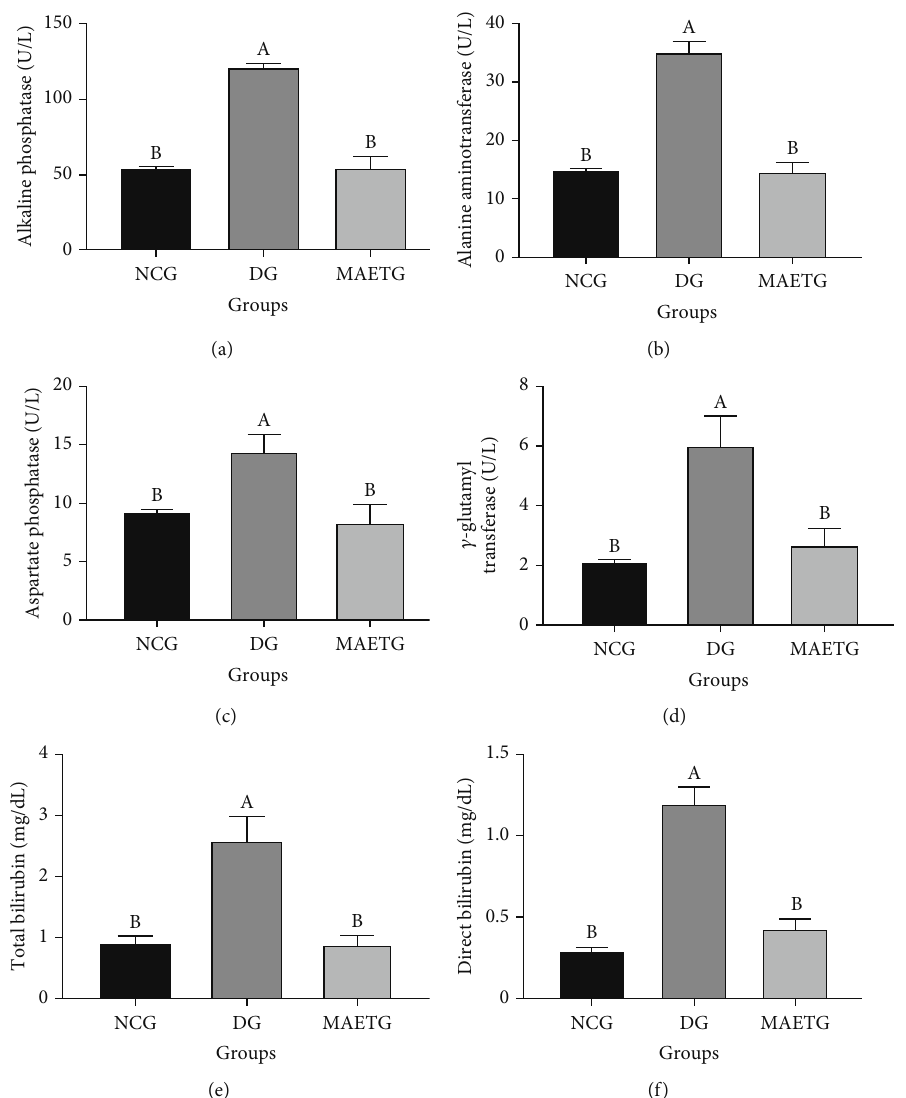
Figure 1: The e ff ects of MAE of C. myrrha on liver function parameters ((a) alkaline phosphatase, (b) alanine aminotransferase, (c) aspartate phosphatase, (d) gamma-glutamyl transferase, (e) total bilirubin, and (f) direct bilirubin) of STZ-induced diabetic rats. Data were presented as mean ± SD . Data were analyzed using ANOVA followed by LSD. The mean di ff erence is signi fi cant at p < 0 : 05 . Each group contained 10 rats. Di ff erent superscript letters (A and B) denote signi fi cance, while similar letters denote no signi fi cance between